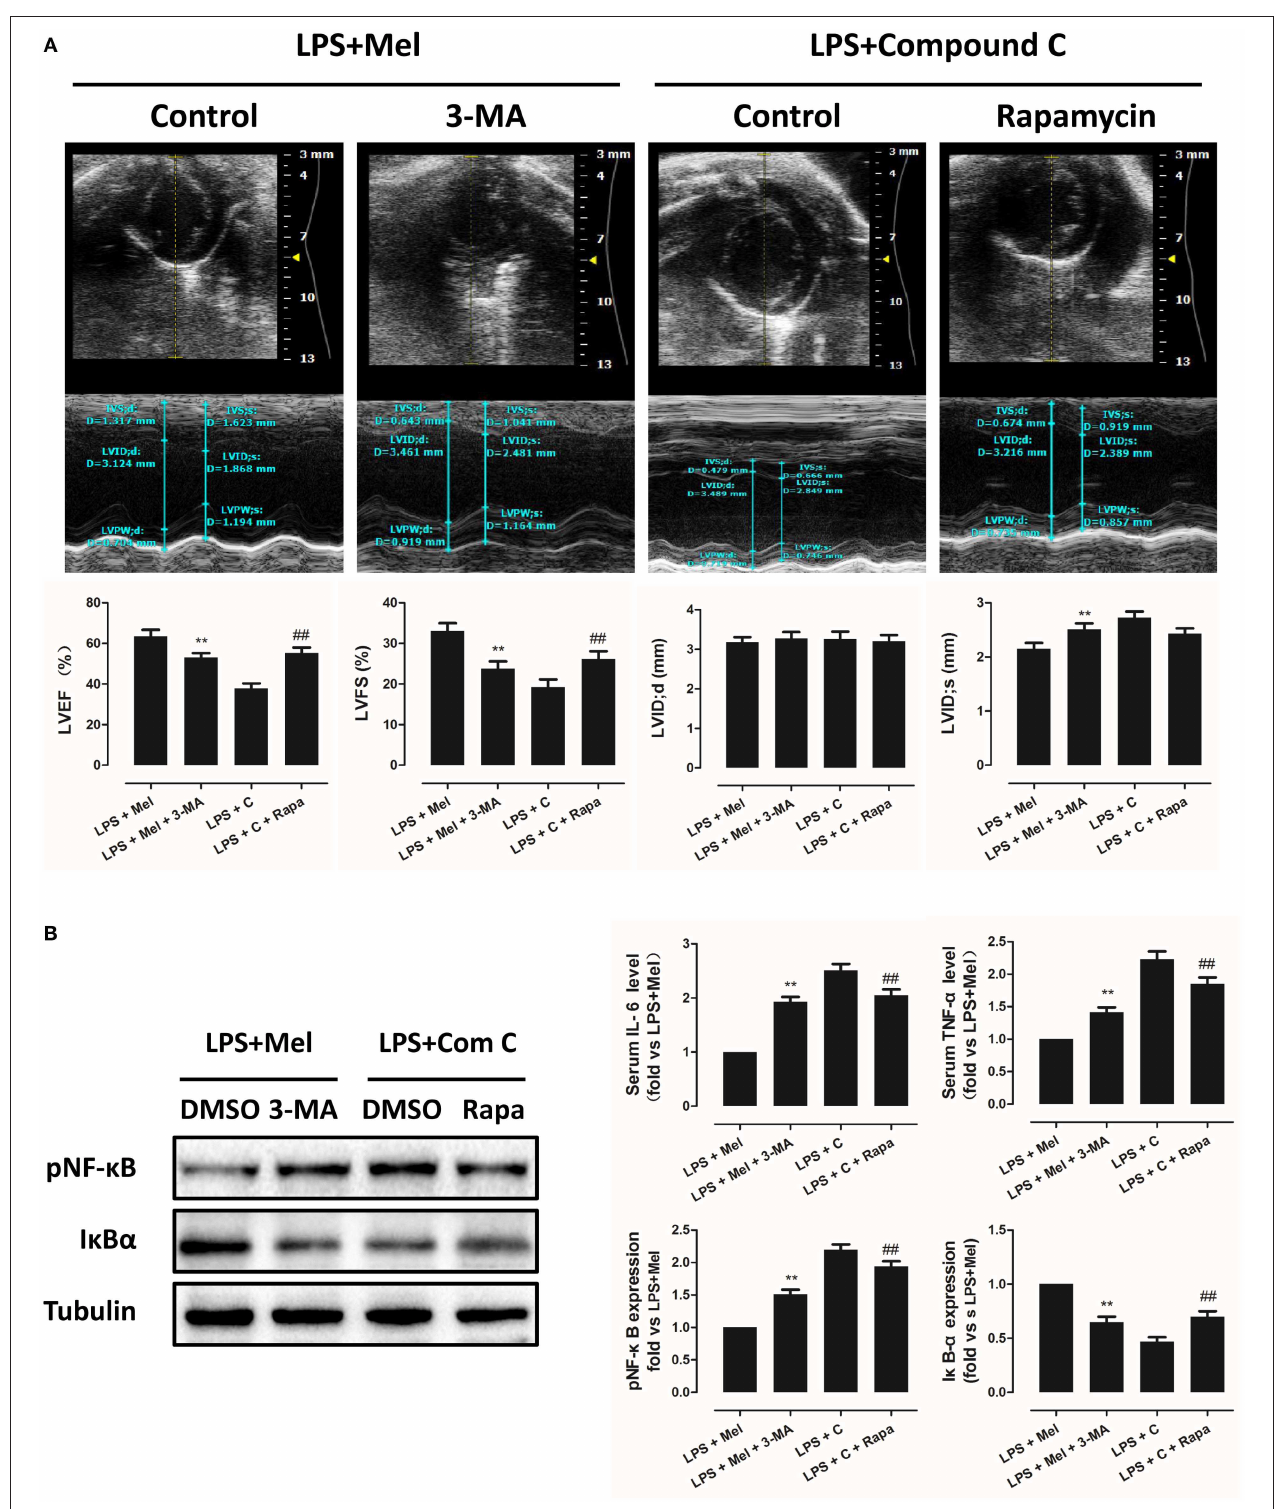
FIGURE 7 | Autophagy inhibition impaired the cardiac protection of melatonin, and autophagy activation rescued AMPK inhibition induced cardiac injury. (A) Representative M-mode echocardiograms from mice in each group and quantitative analysis of mice LVEF, FS, LVID; d, LVID; s. (B) Representative bands of pNF- κ B and I κ B α , and quantitative analysis of pNF- κ B, I κ B α expressions and Serum IL-6, TNF- α levels. n = 6. ** P < 0.05 vs. the LPS + melatonin group, ## P < 0.05 vs. the LPS + Compound C group. Mel, melatonin; C, Compound C; Rapa, rapamycin.